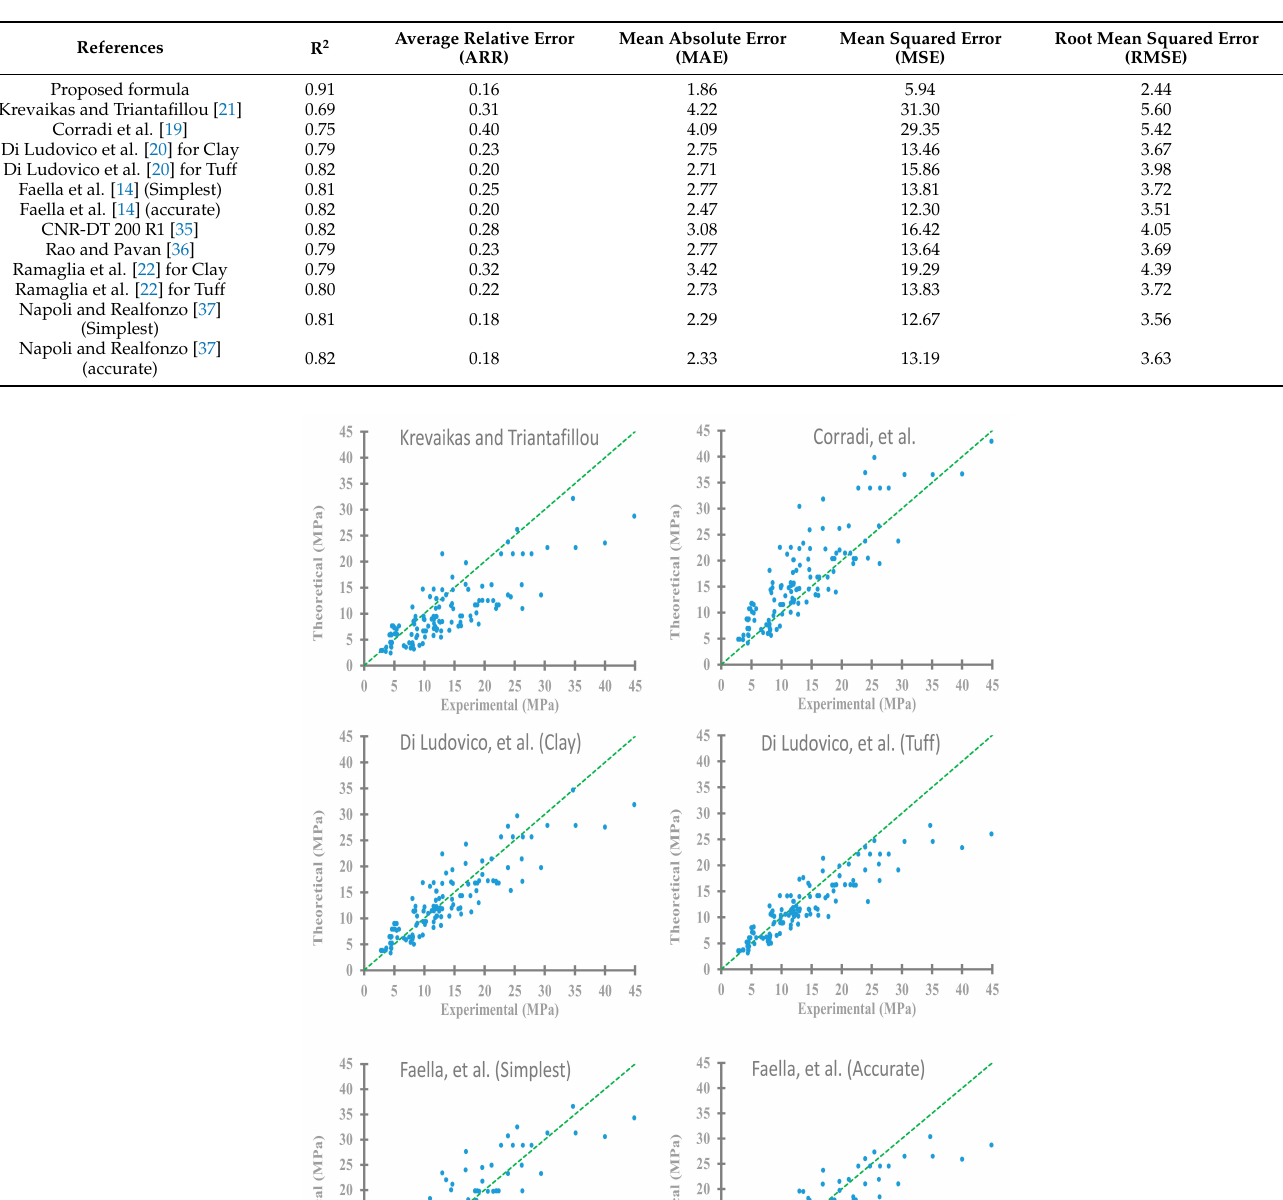
Table 7. Statistical values of gaining strength of FRP confined concrete prisms.